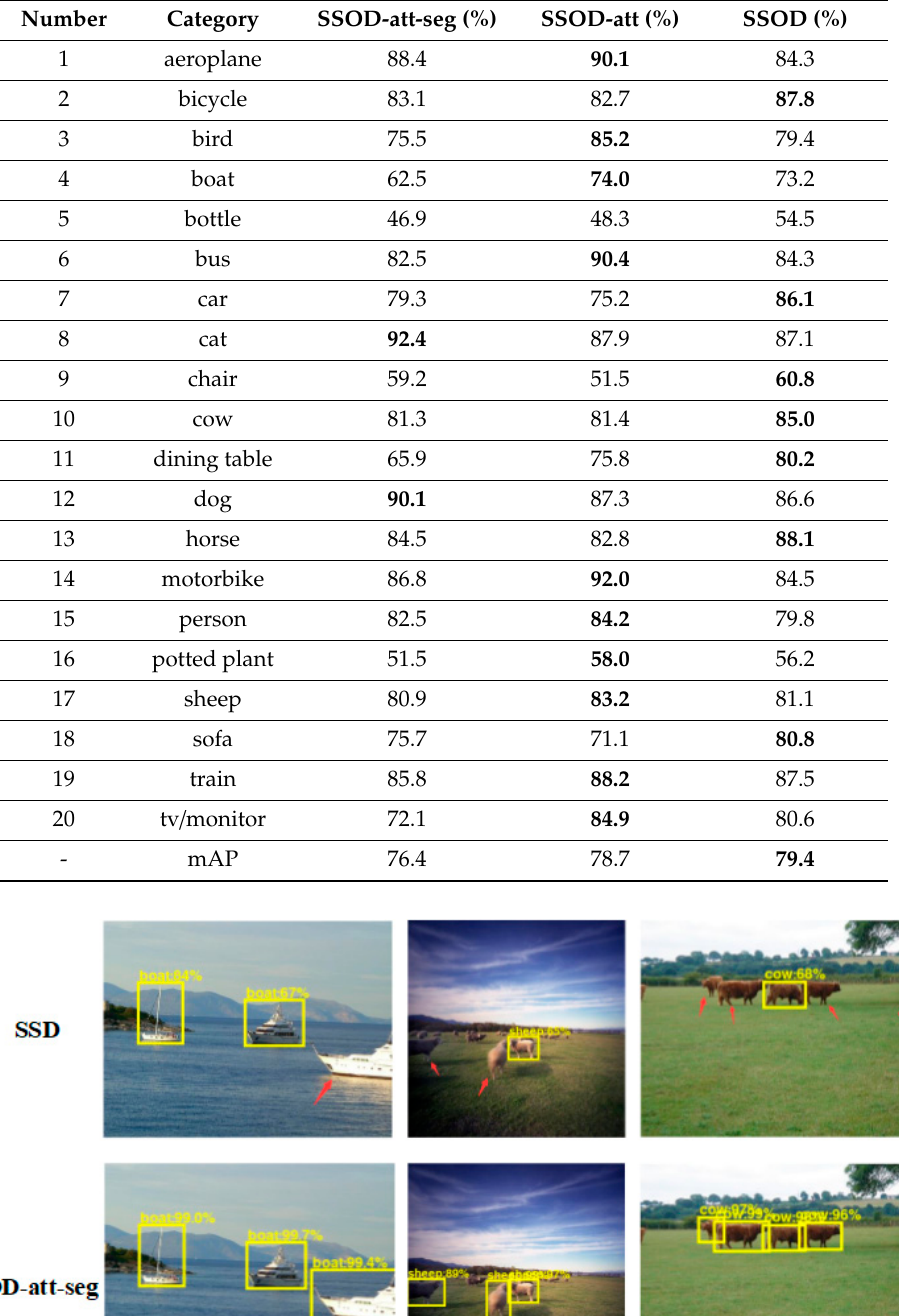
Table 4. Comparison of our algorithm and two variants in terms of mAP values (%) on the Pascal VOC 2012 dataset. The best accuracy is shown in boldface.